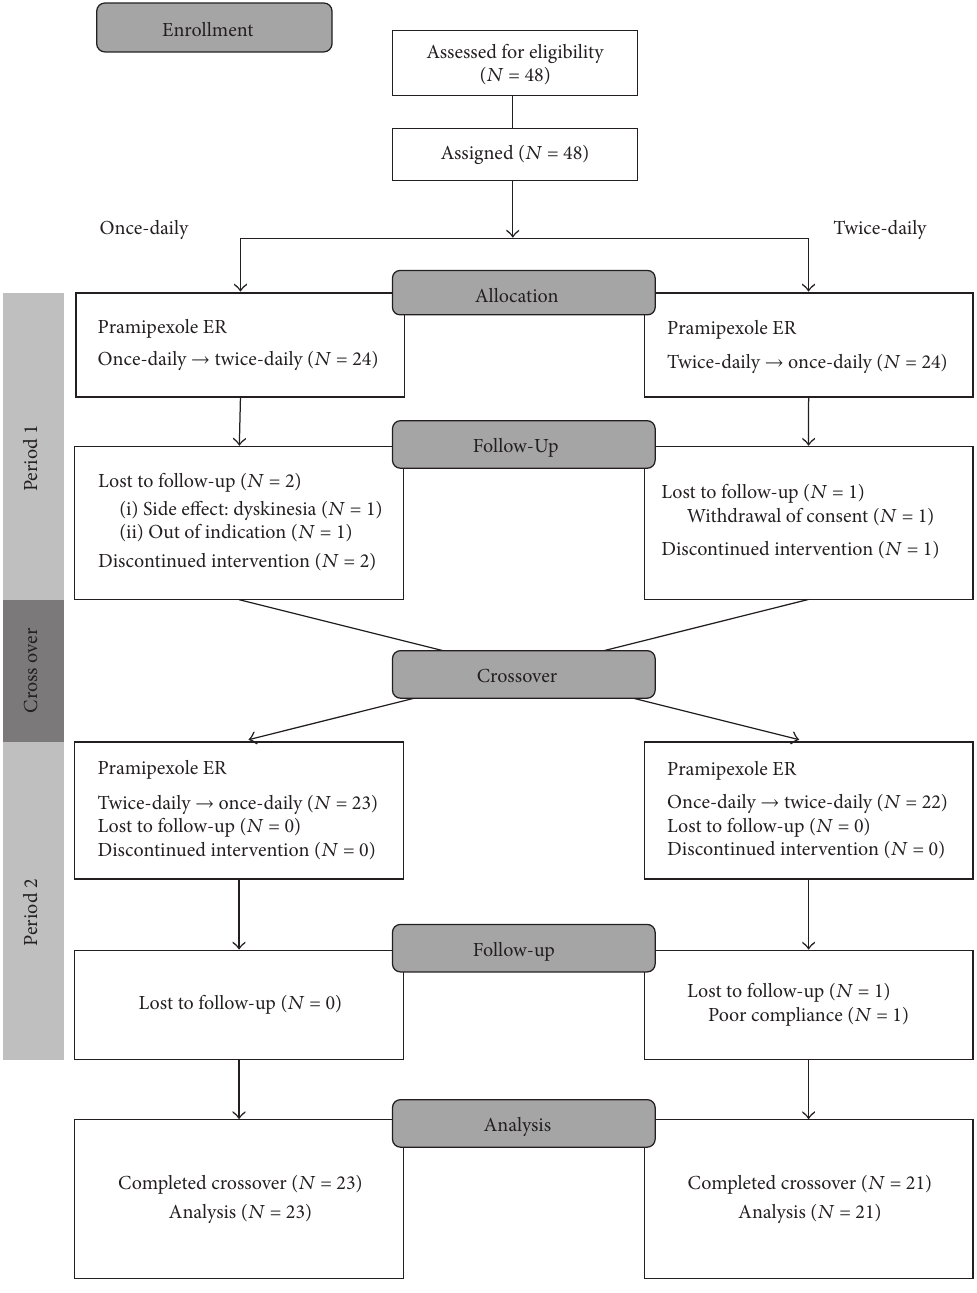
Figure 2: Subject flow